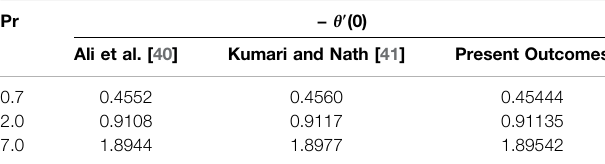
TABLE 2 | Comparative outcomes of − θ ′ (0) for diverse values of Pr , setting all other parameters zero.